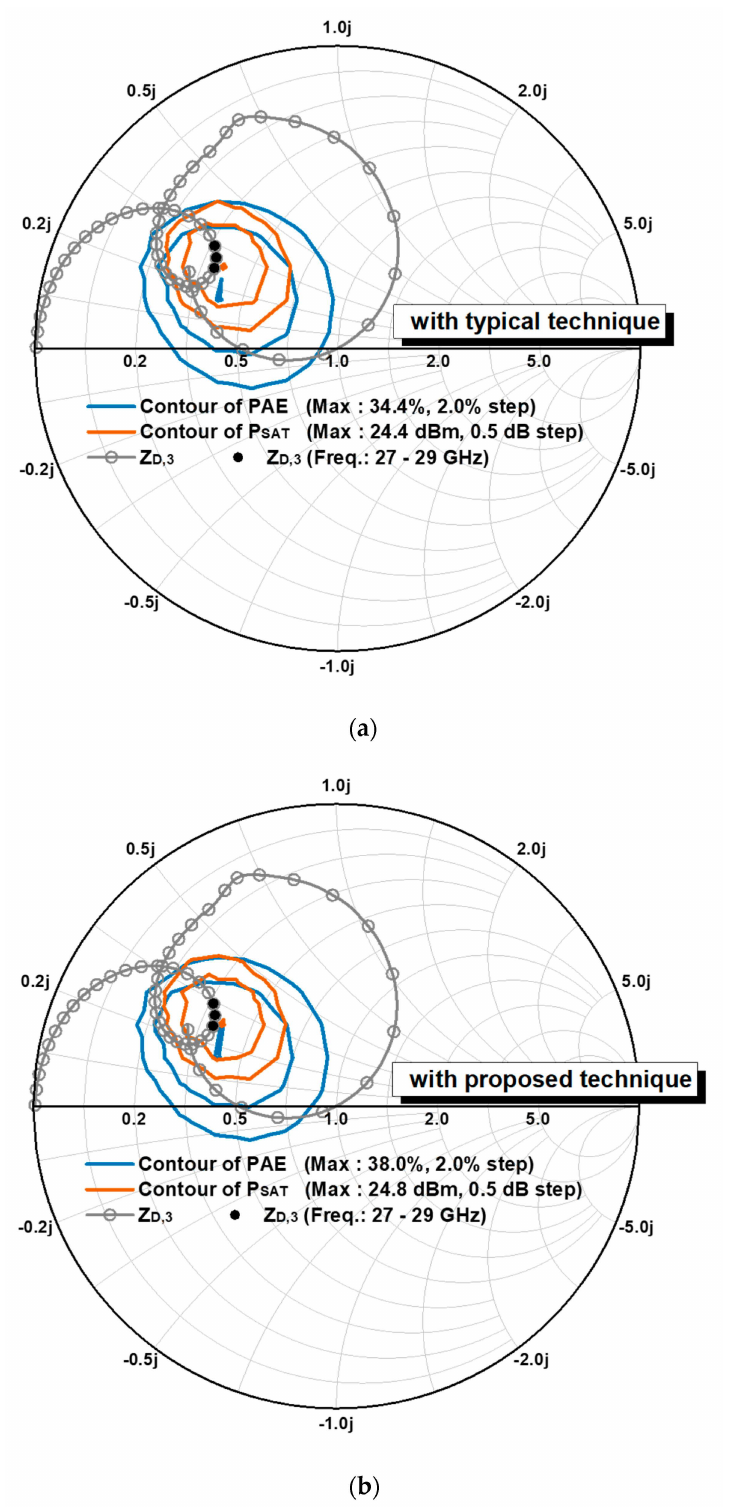
Figure 11. Load-pull simulation results of stacked power stage with ( a ) typical and ( b ) proposed layout